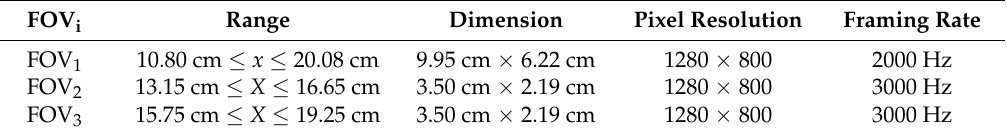
Table 1. A list of the range, dimension, pixel resolution and framing rate for each field of view (FOV) i (i =